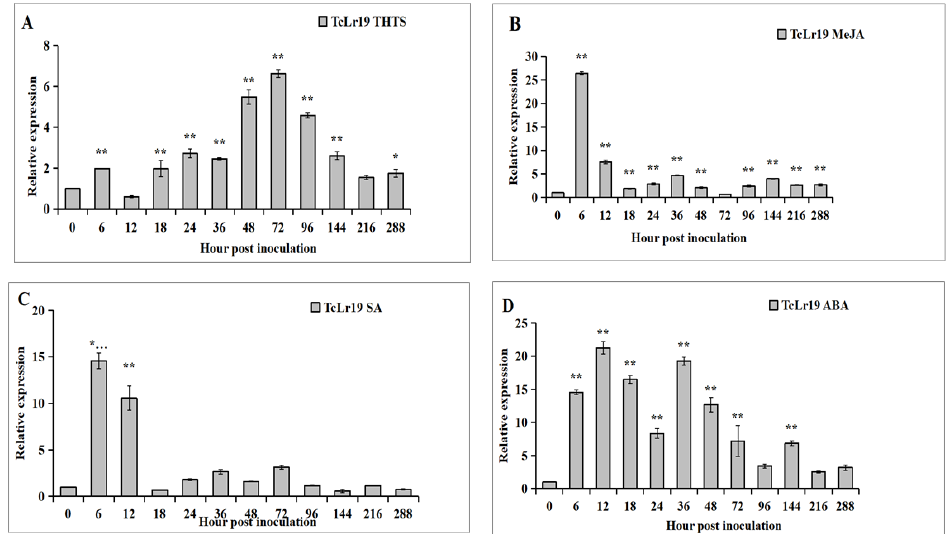
Figure 2. Transcription pattern of TaABCG36 in TcLr19 treated with THTS ( A ), MeJA ( B ), SA ( C ), and ABA ( D ). *: p < 0.05, **: p < 0.01, *** p < 0.001, ( n =